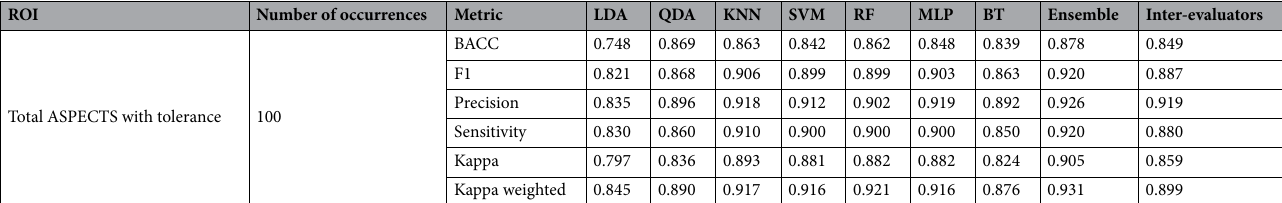
Table 3. Comparison of performance of ML models and inter-annotators in the external testing set (n = 100). For the total aspects "whit tolerance", predicted ASPECTS within ± 1 difference from the ground true ASPECTS were considered true positives.